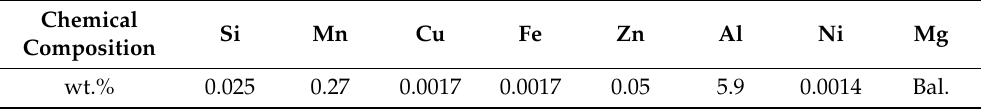
Table 1. The chemical composition of the AM60B-Mg alloy